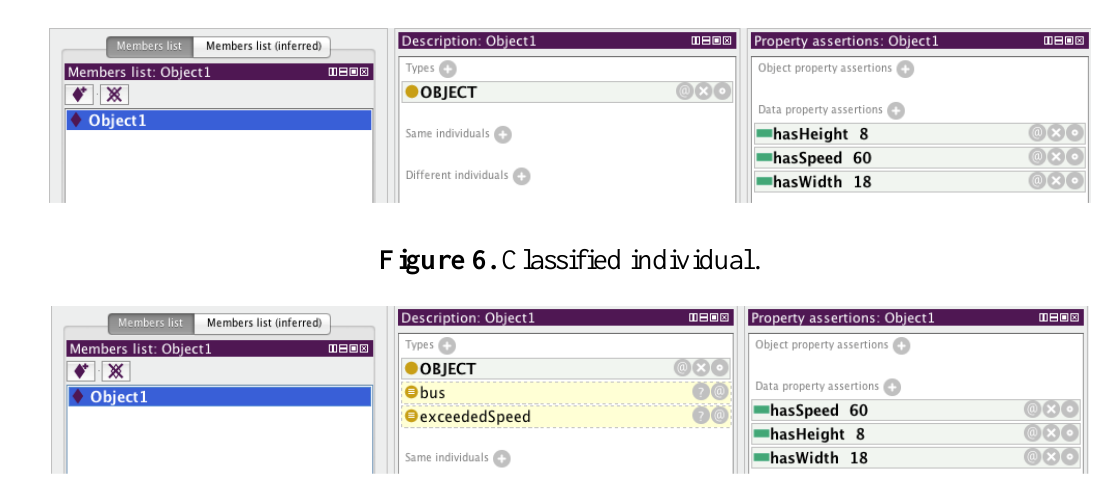
Figure 5. Unclassified individual.